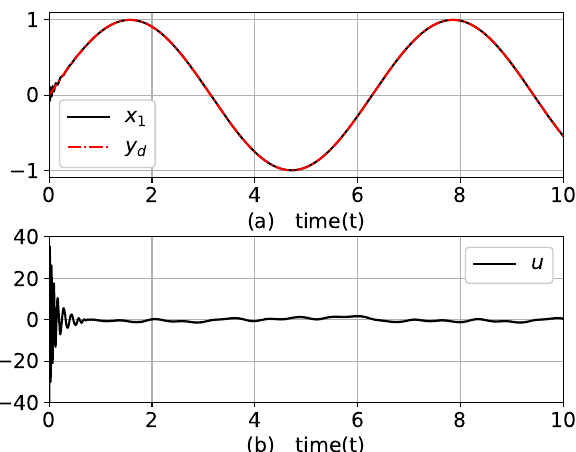
Figure 1. Trajectories of ( a ) y and y d ( b ) control input u with x ( 0 ) = [ 0.1,0 ] T .